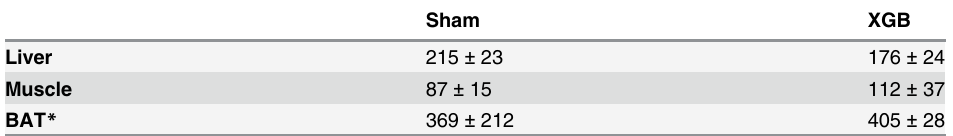
Table 3. Ex vivo palmitate oxidation in brown adipose (BAT), liver and skeletal muscle tissue in cholecystectomized mice. Sham XGB Liver 215 ± 23 176 ± 24 Muscle 87 ± 15 112 ± 37 BAT * 369 ± 212 405 ± 28 Values correspond to the mean ± SD (nmol/mg of wet tissue/h) of 3 animals per group. Tissue samples were harvested and processed as described in “ Methods ” . Data correspond to total plamitate oxidation rate. No signi fi cant differences were found between groups.